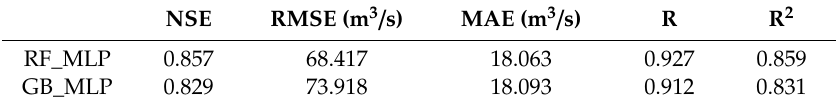
Table 6. Prediction accuracy results of combined machine learning (CombML)